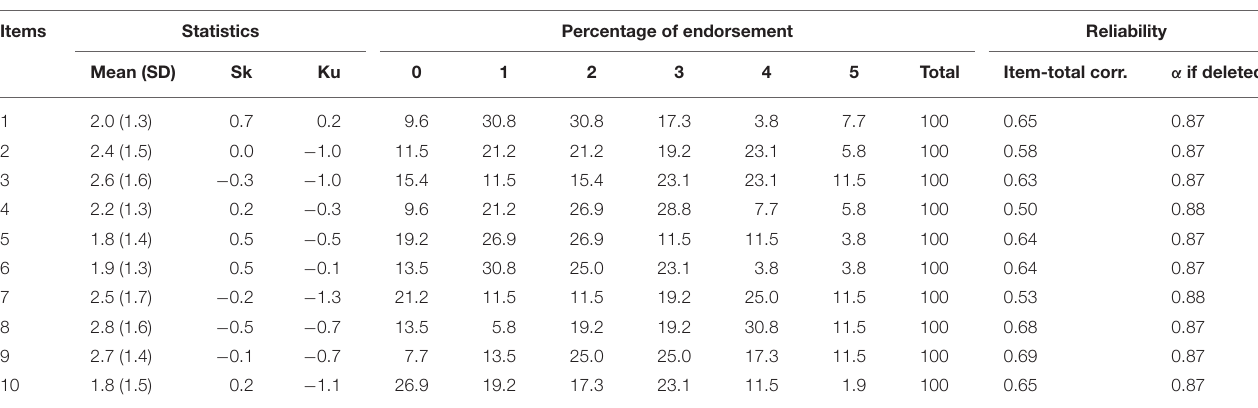
TABLE 2 | Individual Y-BOCS-II item summaries for the OCD